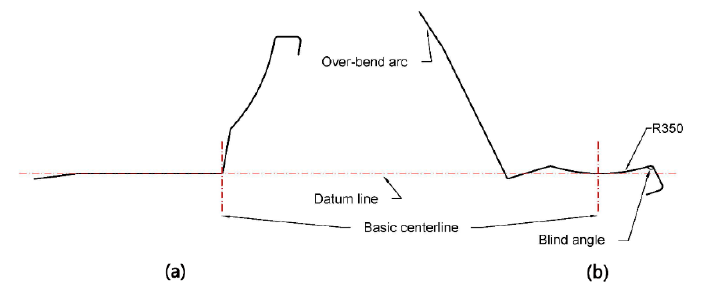
Figure 4. ( a ) Traditional method of placement; ( b ) optimal method of placement.